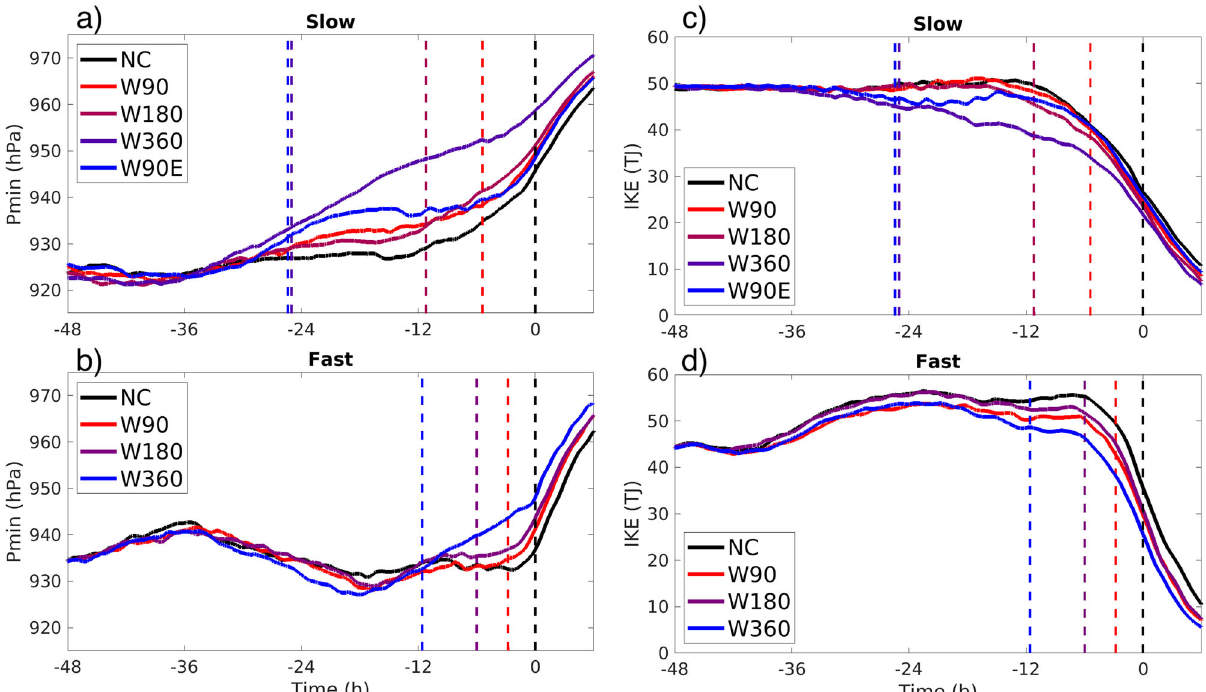
Fig. 4 Time-series of minimum central surface pressure and integrated kinetic energy for all simulations. Time-series of P min for the a slow and b fast experiments beginning 48 h before landfall. The colored vertical dashed lines indicate the time that the corresponding TC center reached the cool patch boundary, and the black vertical dashed line indicates the time that each TC made landfall. A one-hour running average was applied to each time-series. c , d As for a and b , for IKE TS (TJ).